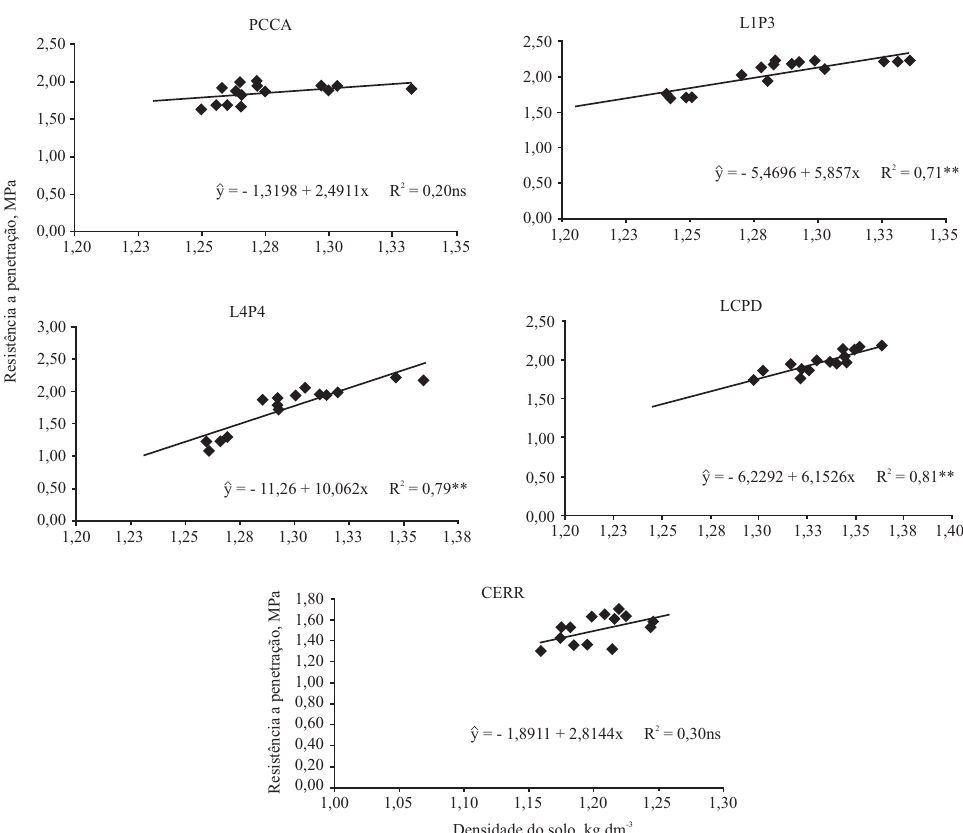
Figura 2. Relação entre a resistência do solo à penetração com a densidade do solo em diferentes sistemas de manejo no Cerrado. ns: não significativo, * e ** significativo a 5 e 1 %, respectivamente. CERR: solo com vegetação natural; PCCA: solo com pastagem contínua e adubada; L1P3: solo sob lavoura de soja por um ano e por três anos com pastagem de Brachiaria brizantha ; L4P4: solo sob lavoura por quatro anos e por quatro anos com pastagem de Panicum maximum, e LCPD: solo com lavoura de soja em sistema de plantio direto.